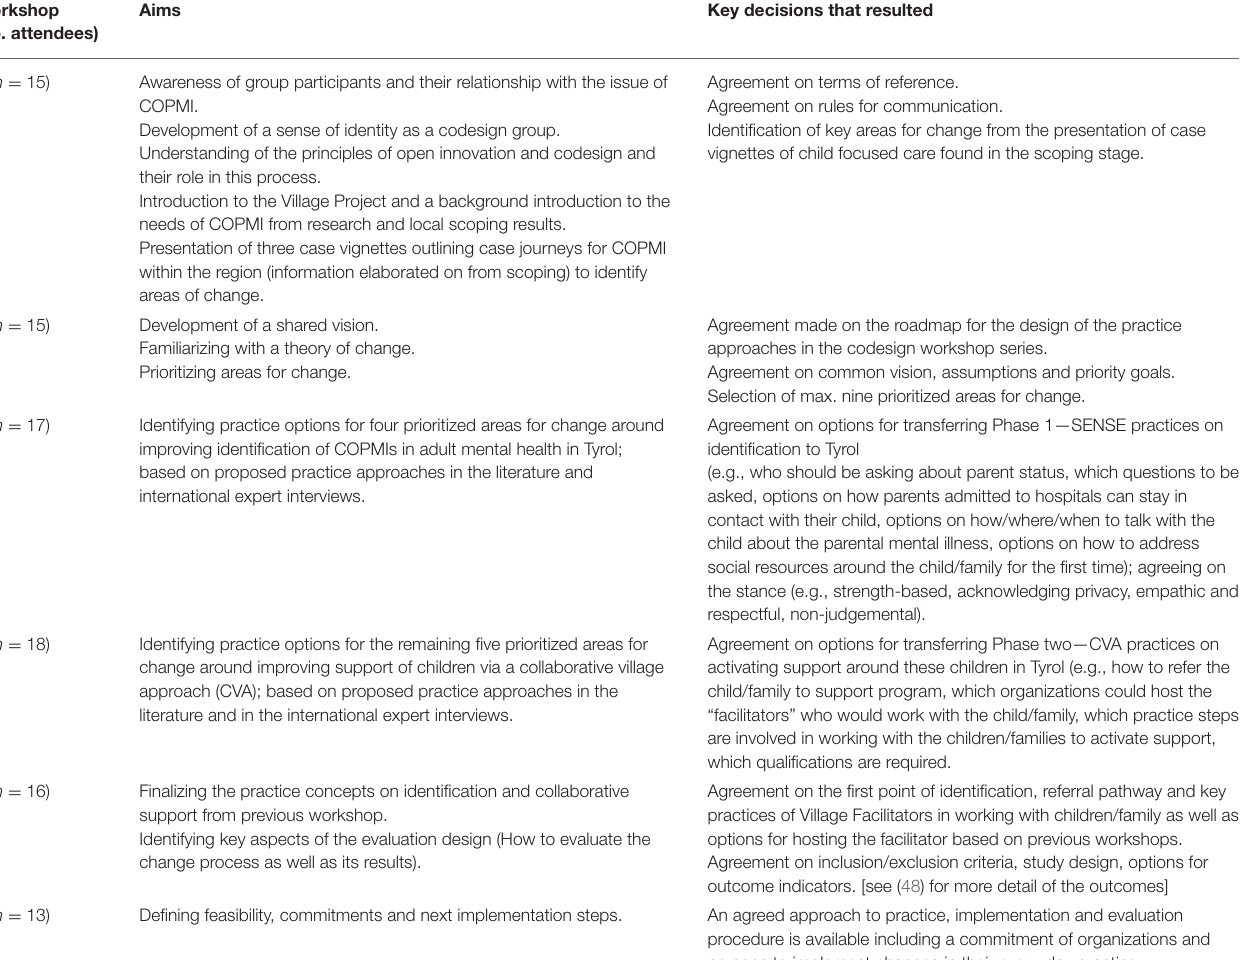
TABLE 2 | Co-design workshop aims and key decisions in the development of the “It takes a Village” practice approach. Workshop Aims Key decisions that (no. attendees)